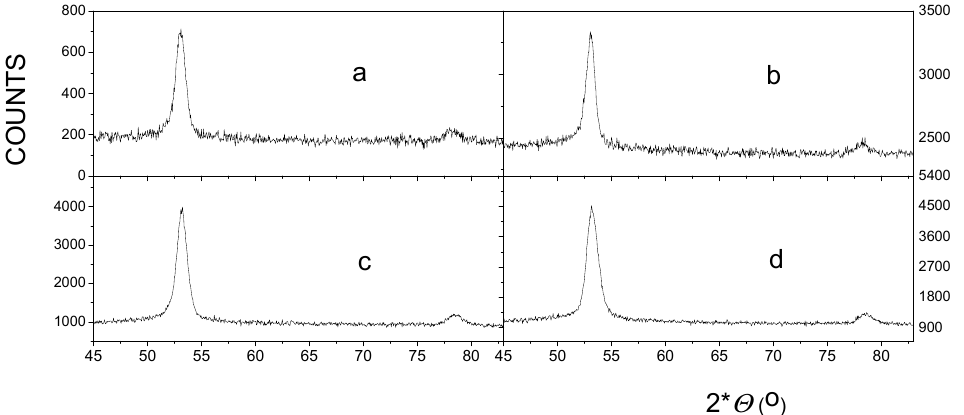
Figure 1. XRDs of FINEMET samples CK021 ( a , c ) and CK022 ( b , d ), non-irradiated ( a , b ) and irradiated by 160 MeV 132 Xe ions at a fluence of 10 13 ion cm − 2 ( c , d ).